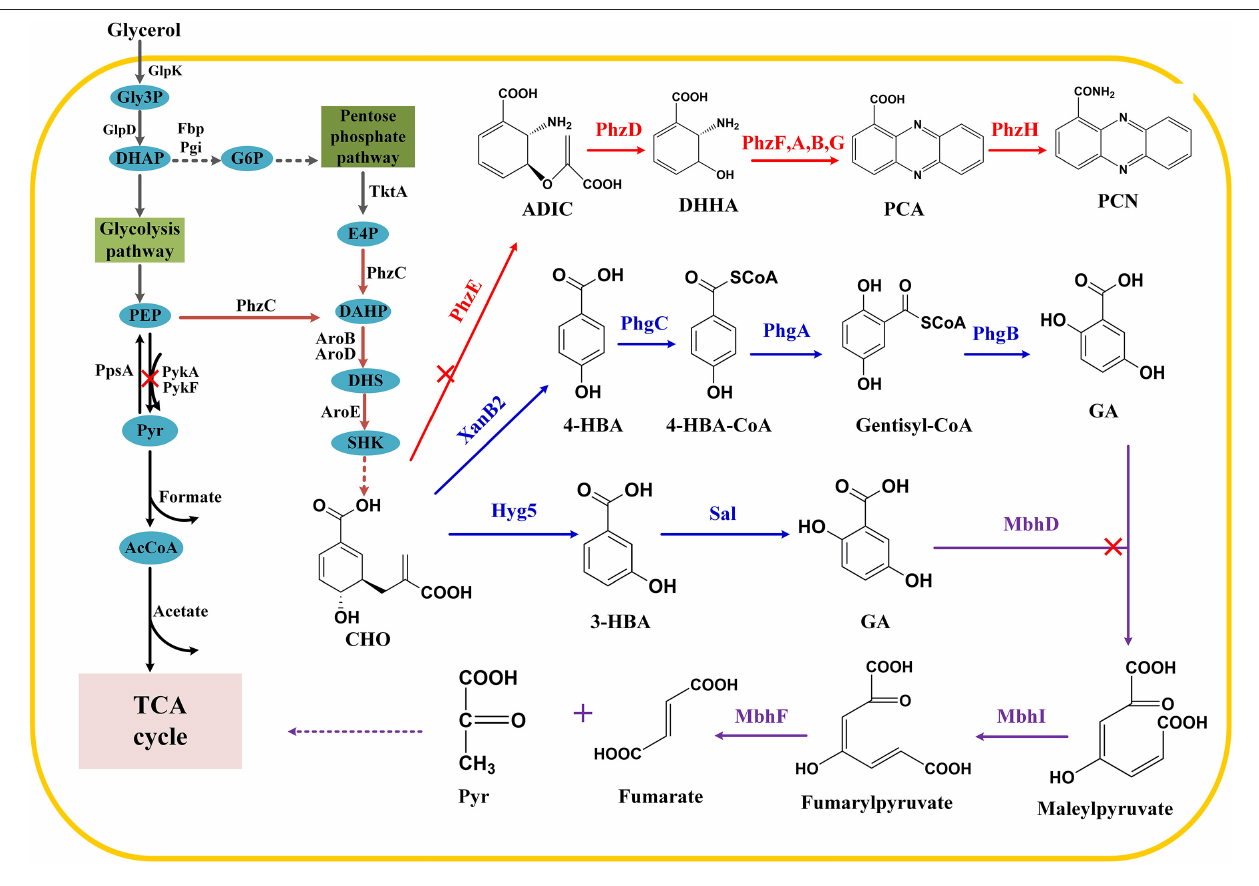
FIGURE 1 | Construction of synthetic pathway for gentisate in P. chlororaphis P3. Gly3P, glycerol-3-phosphate; DHAP, dihydroxyacetone phosphate; GAP, glyceraldehyde 3-phosphate; G6P, glucose-6-phosphate; Pyr, pyruvate; PEP, phosphoenolpyruvate; E4P, erythrose 4-phosphate; DAHP, 3-deoxy-D-arabino-heptulosonate 7-phosphate; DHS, 3-dehydroshikimate; SHK, shikimate; CHO, chorismate; 4-HBA, 4-hydroxybenzoate; 3-HBA, 3-hydroxybenzoate; ADIC, 2-amino-2-desoxyisochorismic acid; DHHA, trans-2,3-dihydro-3-hydroxyanthranilic acid; PCA, phenazine-1-carboxylic acid;